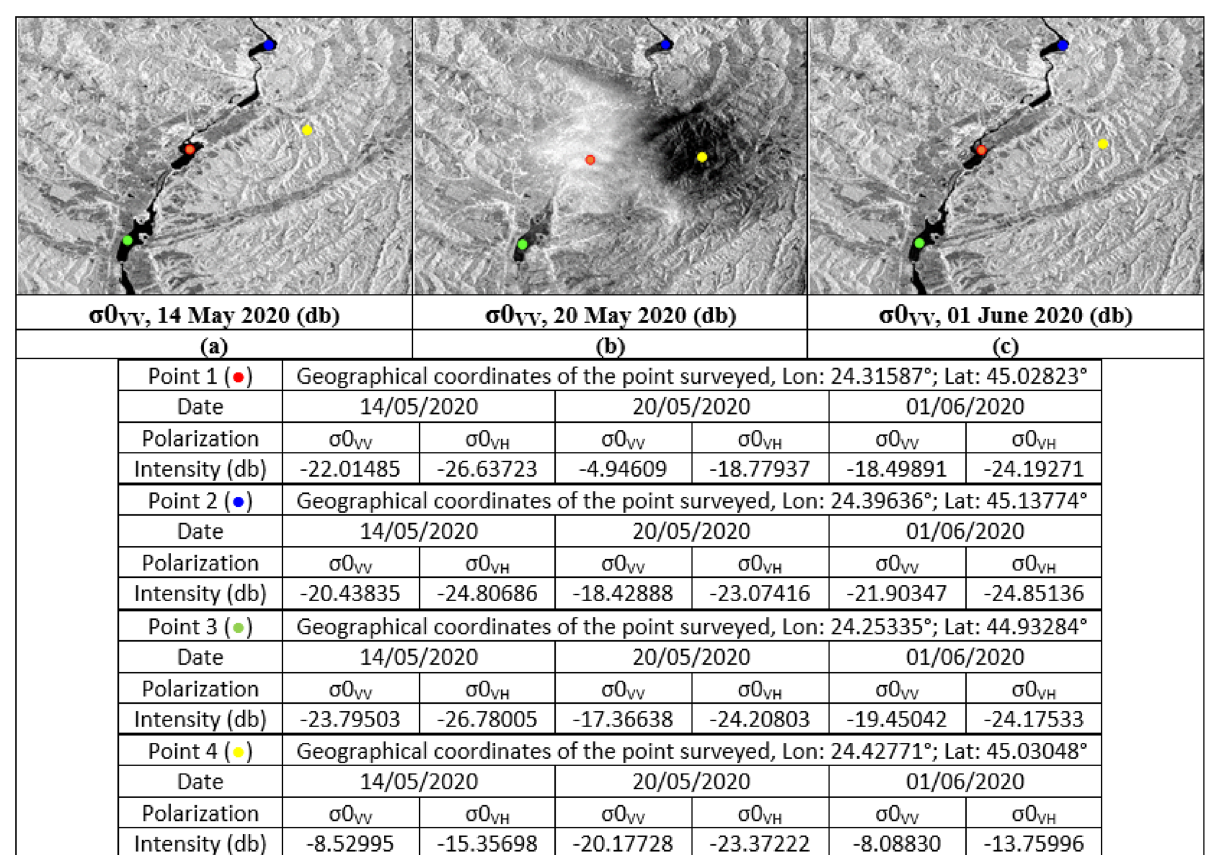
Figure 11. Images showing the points of the location at the level of the Olt River such as between the two banks Stupărie and Ruda for Point 1, ( a ) image before, dated May 14, 2020, VV polarization; ( b ) image during,